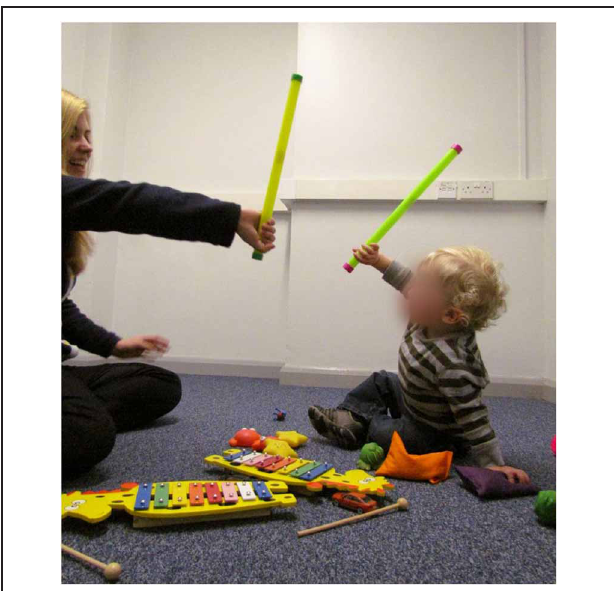
FIGURE 4 | Interventions targeting synchronous motor activity. Child and therapist engaged in Reciprocal Imitation Training (RIT). RIT involves the therapist imitating the child’s actions and gestures, and also modeling developmentally-appropriate actions and gestures for the child to imitate, in a play context. The child is encouraged and prompted to imitate, until regular spontaneous reciprocal imitation is